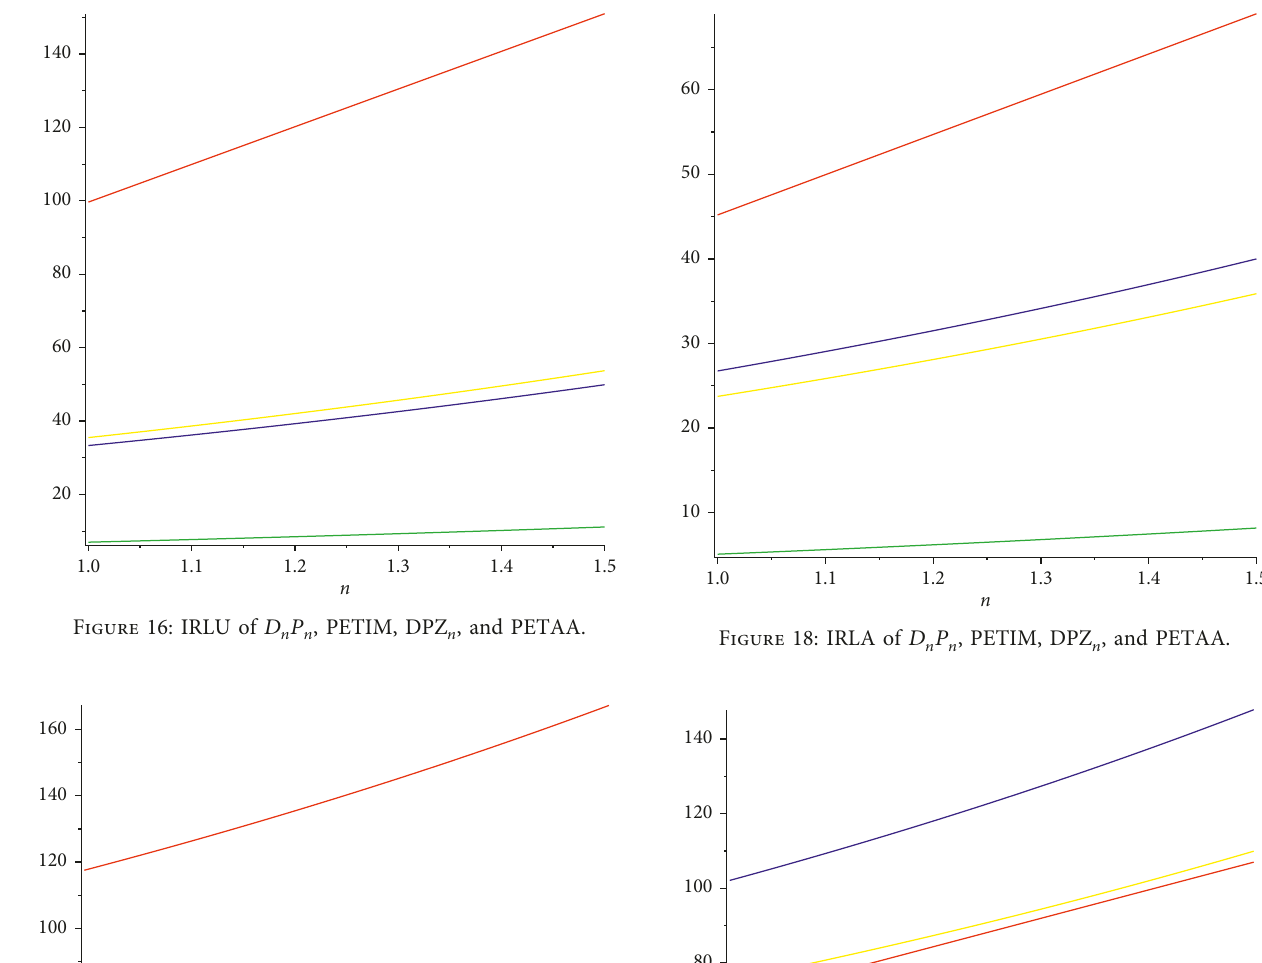
P n n , PETIM, DPZ n , and PETAA.